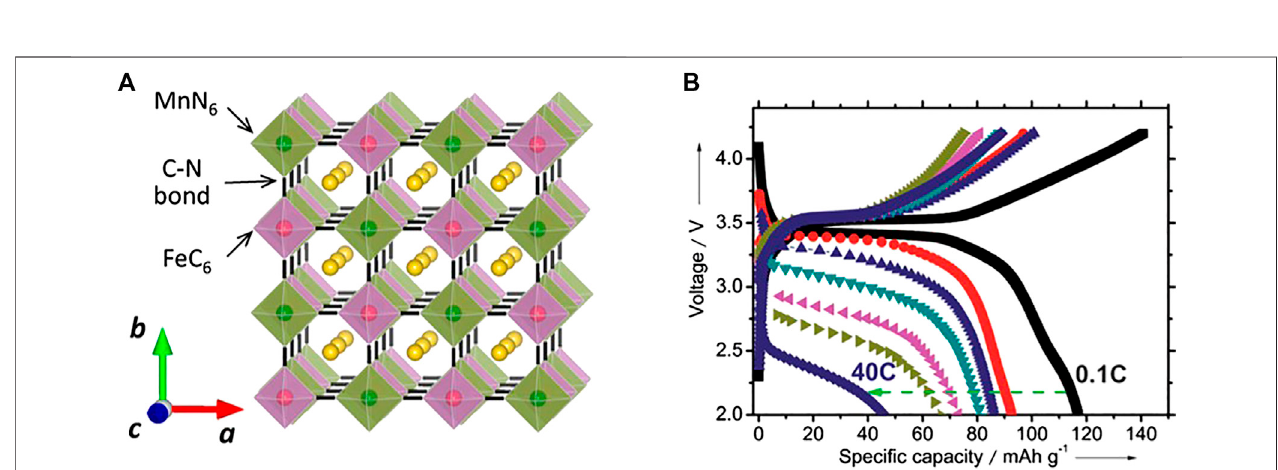
FIGURE2| Crystalstructuresforvanadium-basedpolyanioniccompounds: (A) Na3V2(PO4)3(NASICON-type), (B) Na3V2(PO4)2F3,and (C) Na7V4(P2O7)4PO4. Reprinted with permission from [ref. Yabuuchi et al. (2014)]. Copyright (2014) American Chemical Society.